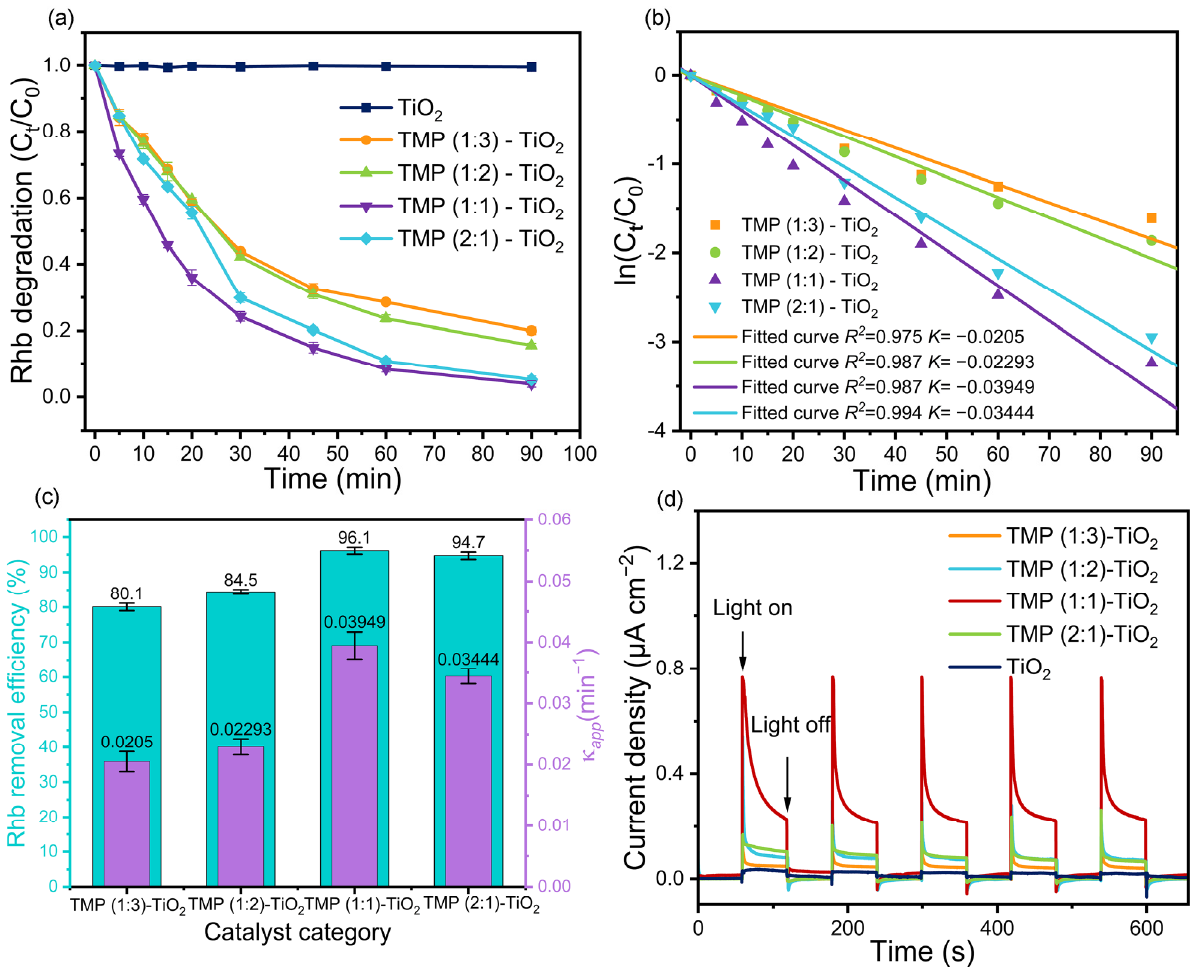
Figure 7. ( a ) Degradation of RhB. ( b ) Hinshelwood plot for studying the kinetic of the process. ( c ) Removal rate of RhB and value of the linear fit κ app . ( d ) Photocurrent response diagram.